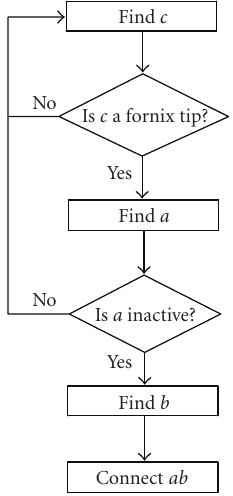
Figure 4: Flow chart of the fornix removal